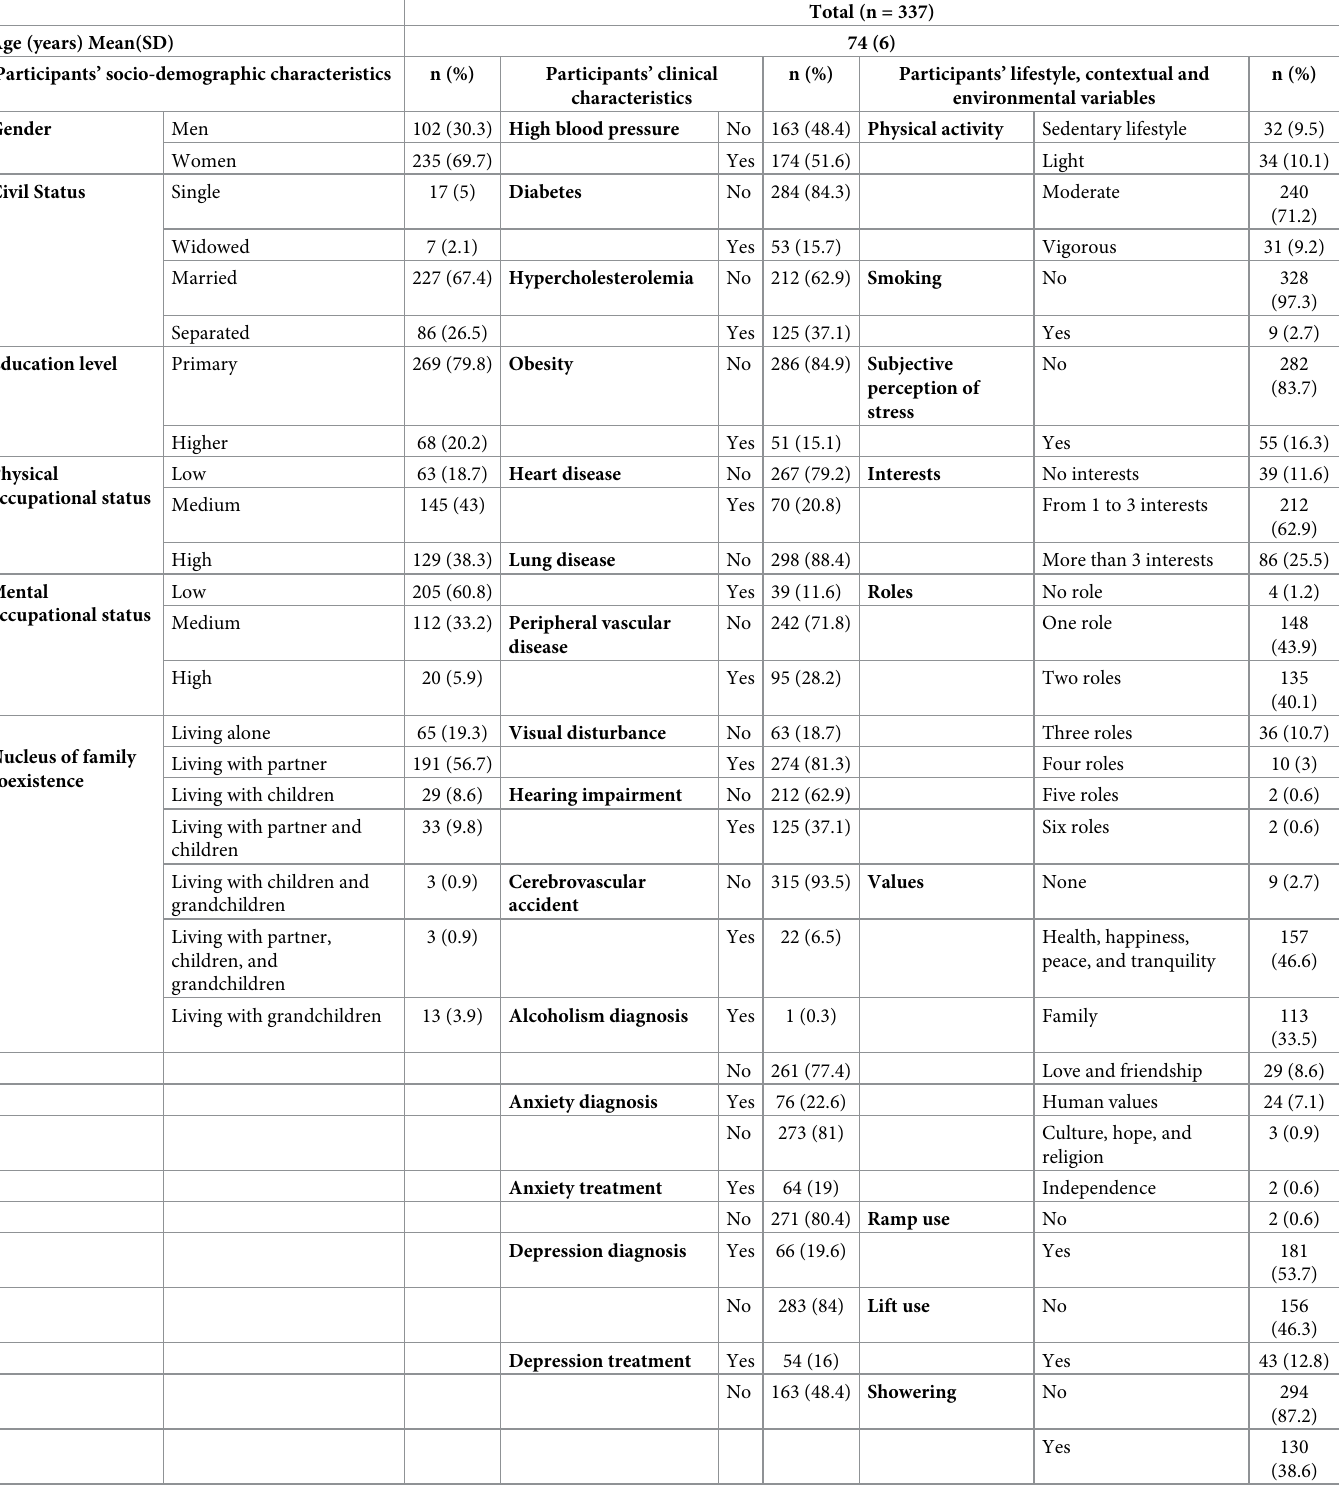
Table 1. The participants’ socio-demographic and clinical characteristics and participants’ lifestyle, contextual and environmental